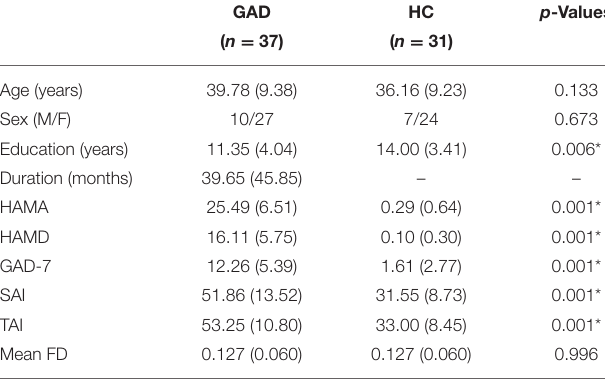
between the right BLA and left superior temporal gyrus/insula showed positive correlation with state (r = 0.293, p = 0.02)